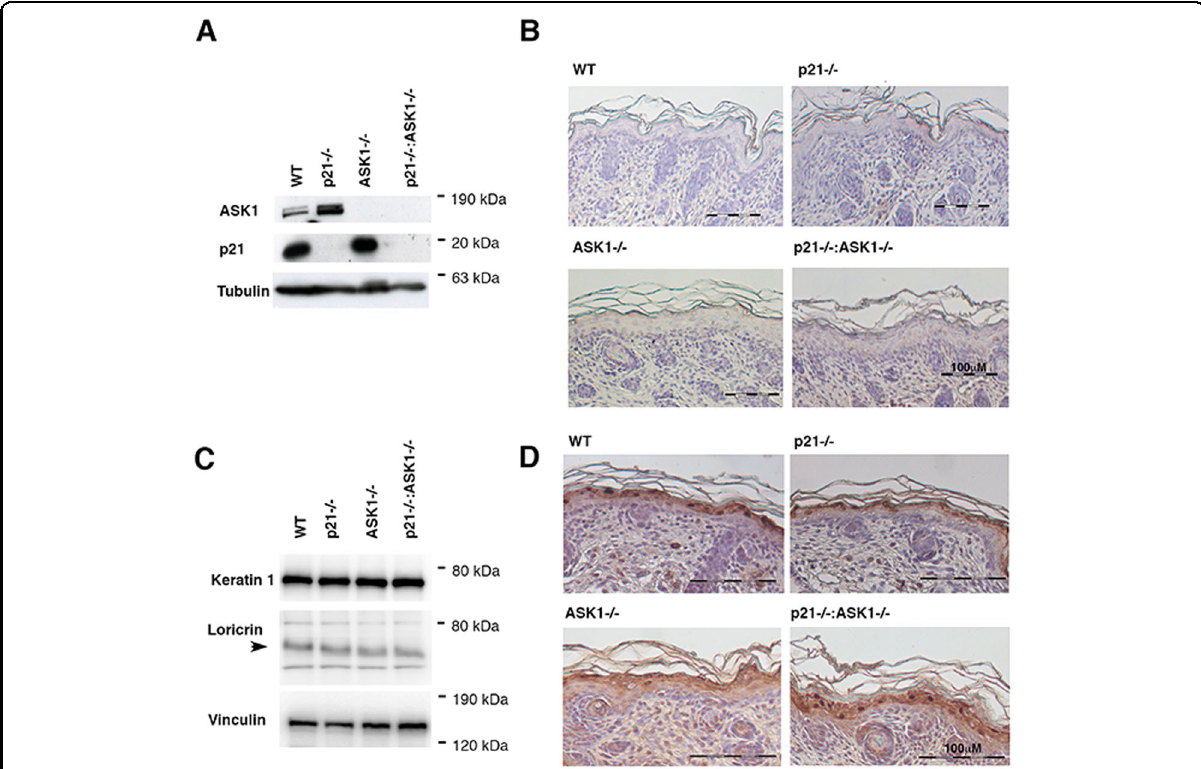
Fig. 1 Inactivation of both p21 and ASK1 has not a major impact on differentiation of keratinocytes. A Primary mouse keratinocytes were established from 2-day-old newborn mice and maintained in low calcium medium. Cells were analyzed for western blot analysis with the indicated antibodies 5 days post-seeding. B H&Es taining of single p21KO, ASK1KO, ASK1/p21KO, and wild-type (WT) skin at birth (2-day-old newborn mice). 10X microscope fi eld (scale bar: 100 μ m). C Equal amounts of protein extract from WT, p21KO, ASK1KO ASK1/p21KO neonate dorsal skin (2-day-old newborn mice) were separated by SDS-PAGE and analyzed by western blot with antibodies directed against keratin 1 and loricrin. Vinculin has been used as a loading control ( D ) Immunohistochemical labeling of dorsal skin sections from 2-day-old newborn WT, p21KO, ASK1KO ASK1/p21KO mice using antibodies speci fi c to loricrin shows a similar expression level and localization of the differentiation marker in WT and KO mice. 20X microscope fi eld (scale bar: 100 μ